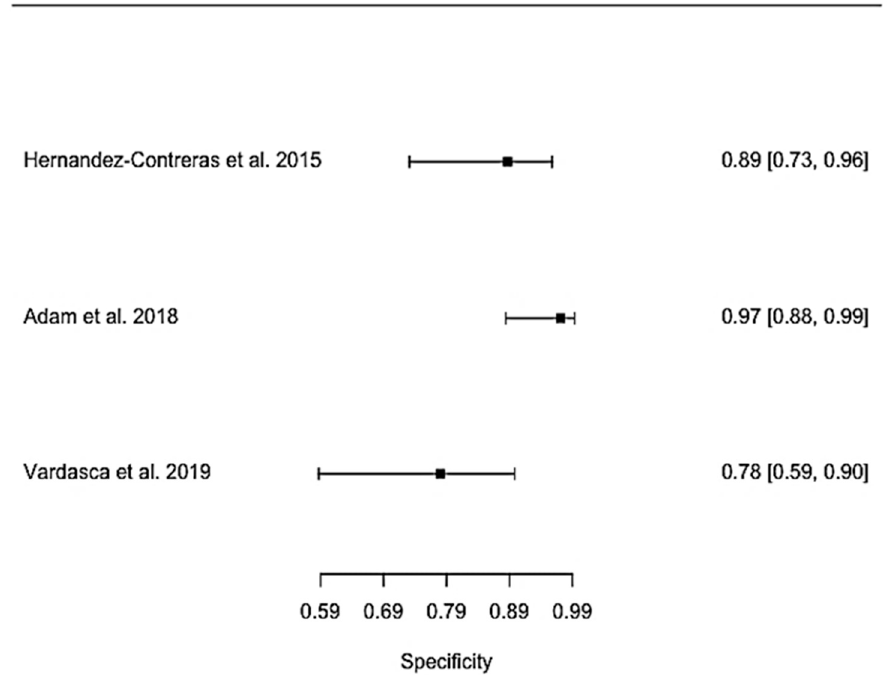
Figure A5. Forest plots for specificity for diabetic foot studies.